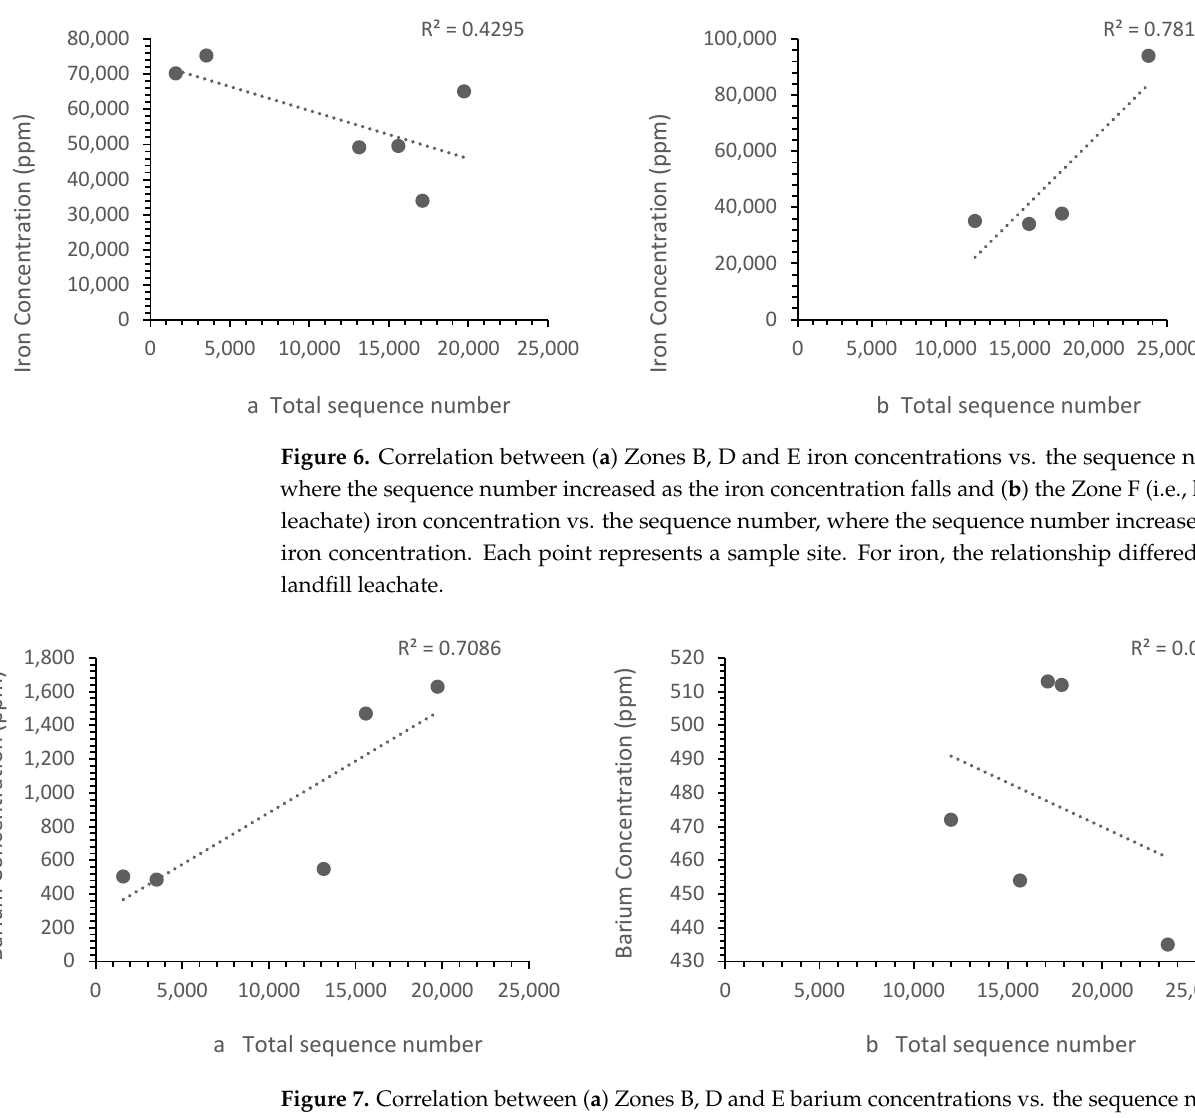
Figure 7. Correlation between ( a ) Zones B, D and E barium concentrations vs. the sequence number, where the sequence number increased as the barium concentration increased and ( b ) the Zone F (i.e., landfill leachate) barium concentration vs. the sequence number, where the sequence number decrease with the barium concentration. Each point represents a sample site. For barium, the relationship differed in the landfill leachate.